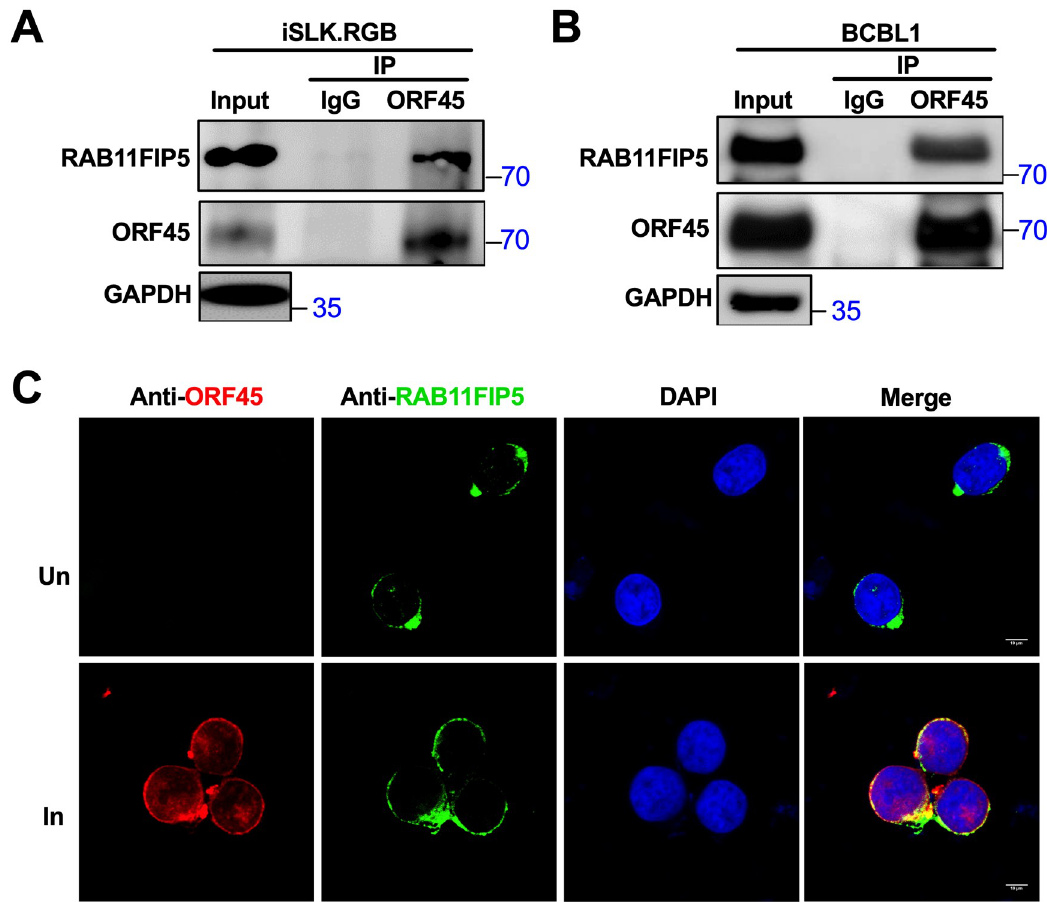
Fig 2. The interaction between endogenous RAB11FIP5 and ORF45. (A) Co-IP of endogenous ORF45 and RAB11FIP5 in KSHV-positive iSLK.RGB cells. Lytic replication of KSHV in the cells was induced by dox, and cell lysates were subjected to immunoprecipitation with the anti-ORF45 antibody or mouse IgG control antibody. Purified proteins, along with input samples, were subjected to western blotting with the indicated antibodies. (B) Co-IP of endogenous ORF45 and RAB11FIP5 in KSHV- positive BCBL1 cells. Lytic replication of KSHV in the cells was induced by VPA, and the cells were treated as described in (A). (C) Endogenous RAB11FIP5 colocalized with endogenous ORF45 in the cytoplasm. BCBL1 cells uninduced (Un) or induced with VPA (In) were fixed and labeled with anti-RAB11FIP5 and anti-ORF45 antibodies and were then incubated with FITC- or Cy3-conjugated secondary antibodies.